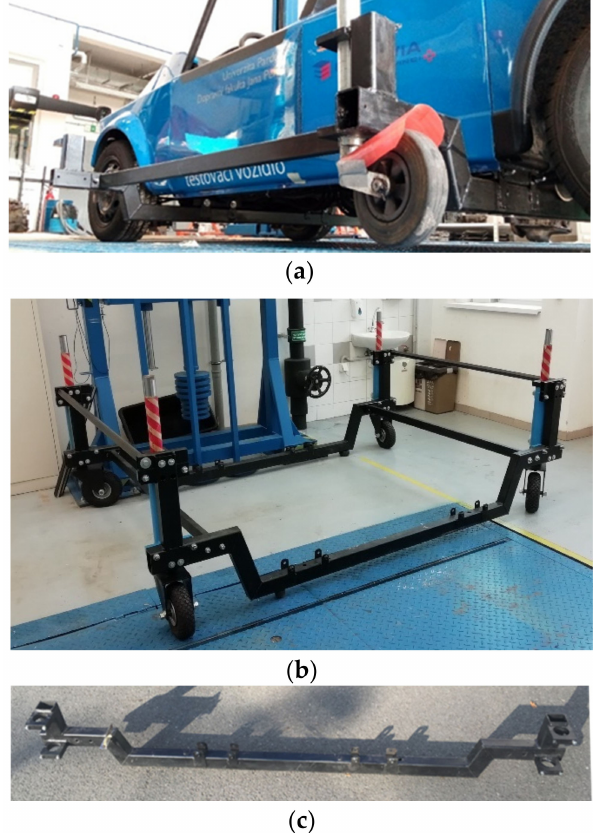
Figure 1. ( a )-Experimental vehicle with the ASC system, ( b ) frame ASC, and ( c ) crossbar ASC. Load Determination on the ASC Frame